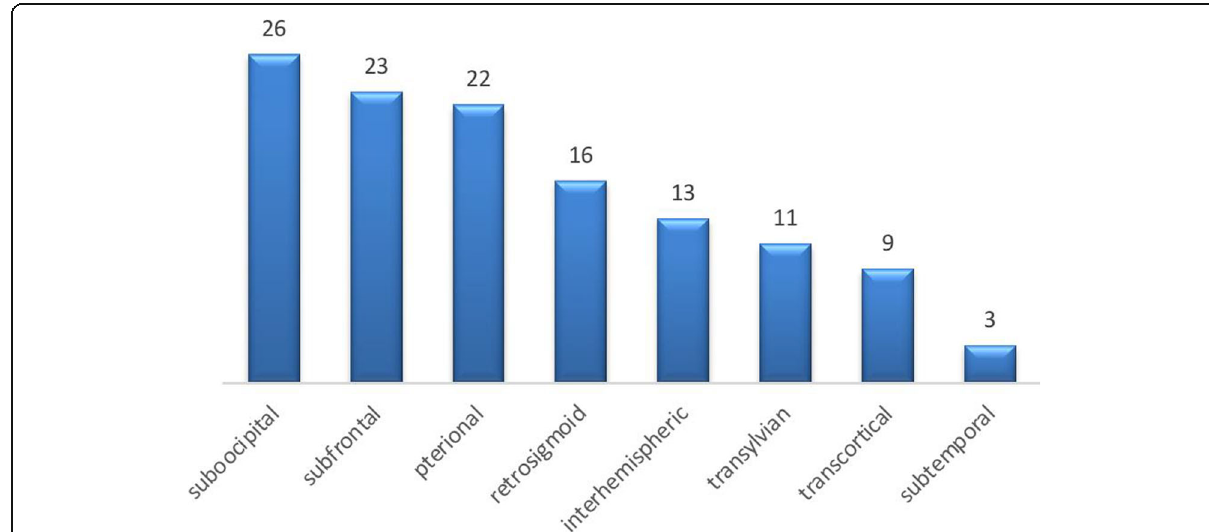
Fig. 6 Chart showing the distribution of approaches used. The number in each column refers to the number of patients where this maneuver was